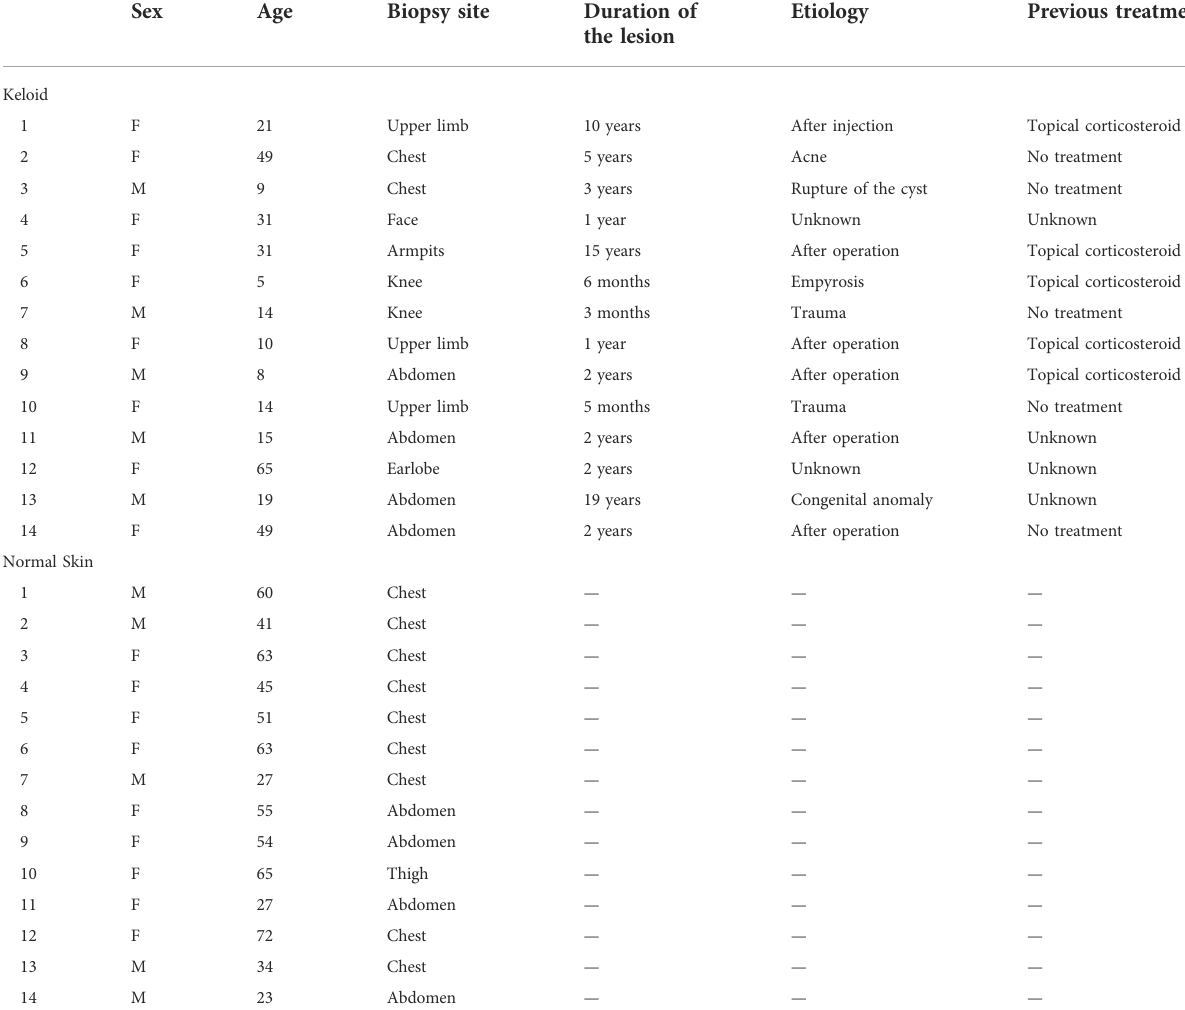
TABLE 1 Information of each